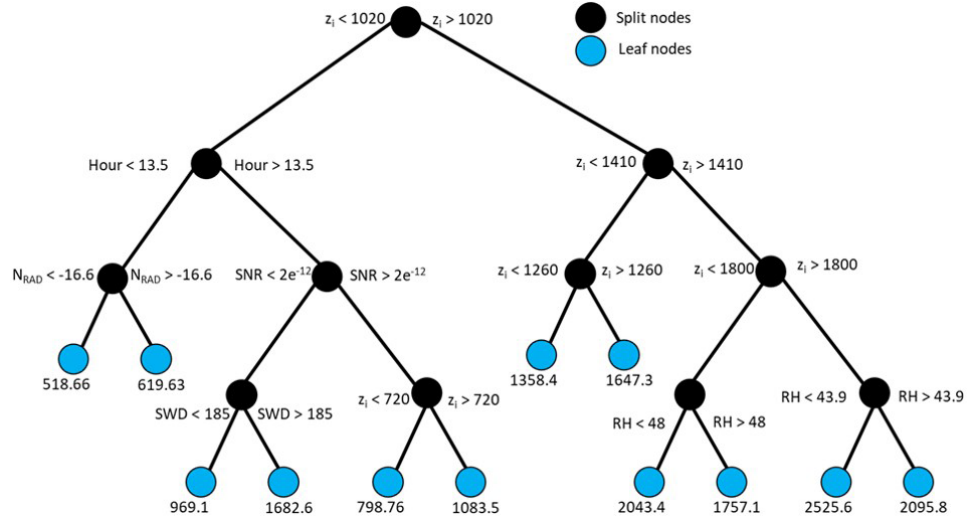
Figure B1. A sample regression tree developed by the RF model. z i is the Tucker method boundary layer height estimate, SNR is signal- to-noise ratio, NRAD is the normal radiation, RH is relative humidity, SWD is surface wind direction, Hour is hour of the day. The black circles represent the split nodes, and the cyan circles represent the leaf nodes developed for this regression tree (a.k.a. boundary layer height estimates from